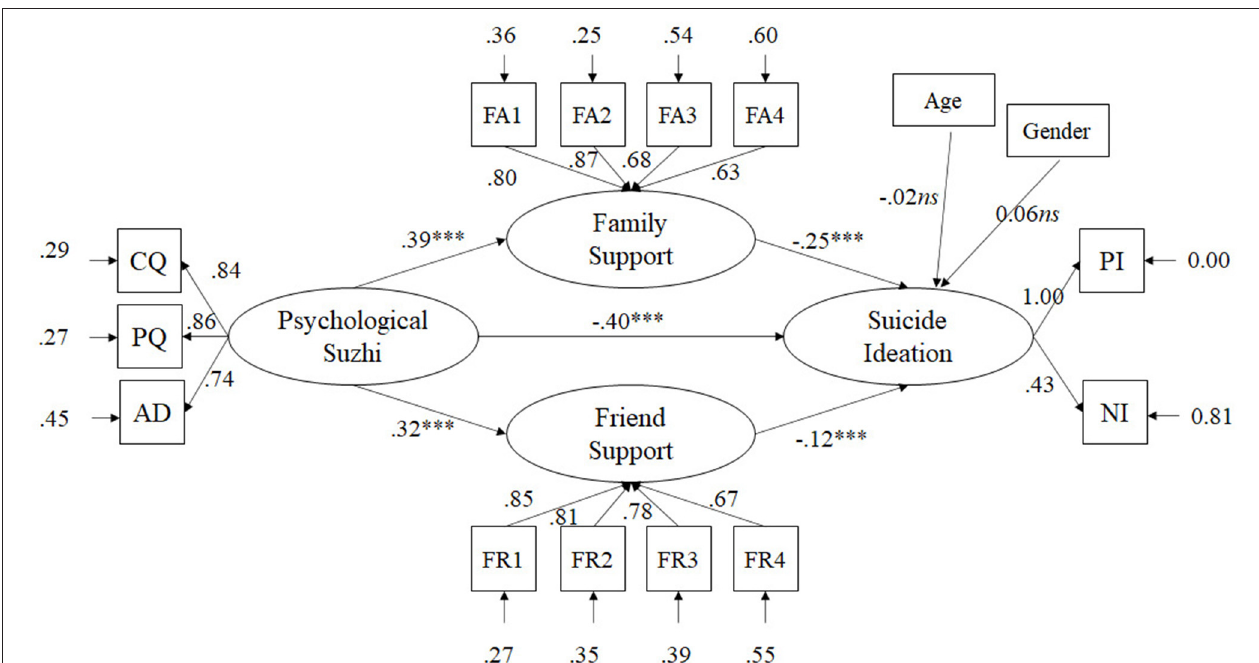
FIGURE 1 | Structural equation model with standardized parameters estimates: psychological suzhi and suicide ideation. CQ, cognitive quality; PQ, personality quality; AD, adaptability; FR, friend support; FR1–FR4, four parcels of friend support; FA, family support; FA1–FA4, four parcels of family support. *** p <